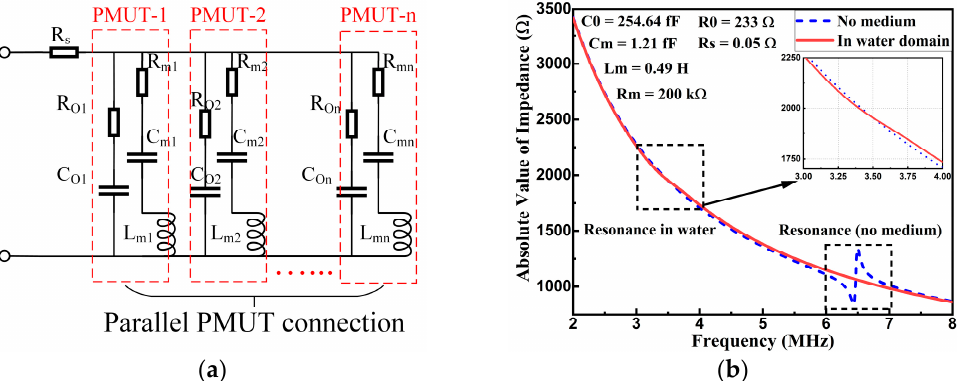
Figure 5. ( a ) The MBVD equivalent circuit model of the PMUT array. ( b ) The simulated frequency response of array impedance for both the no medium and water medium situations.